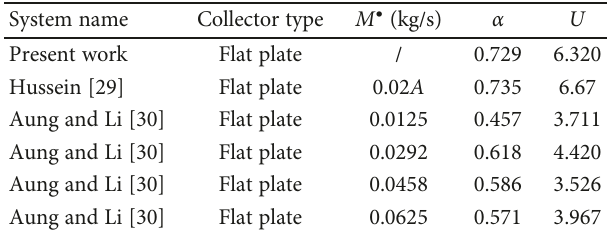
Figure 8: Graphical plot of the experimental results and the linear fi tting. Table 5: Solar collector performance compared with that in previous works.